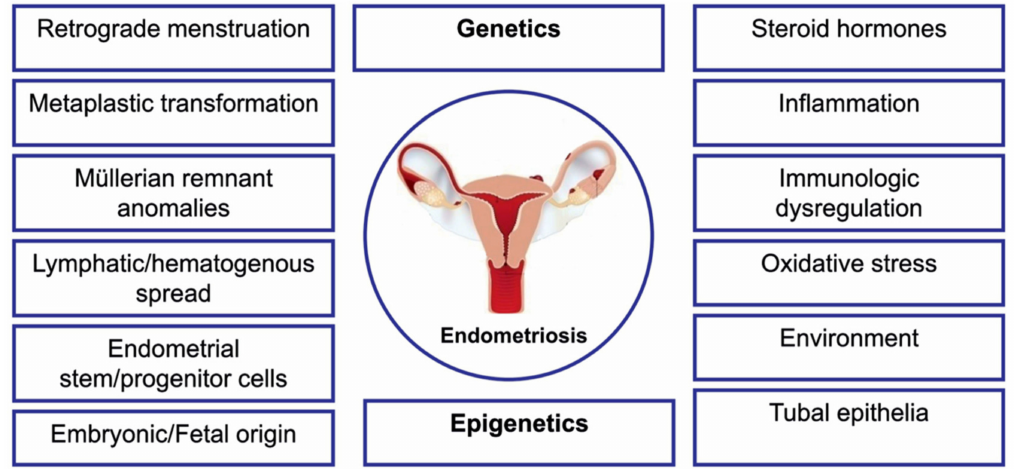
Figure 1. Summary model for the pathogenesis of